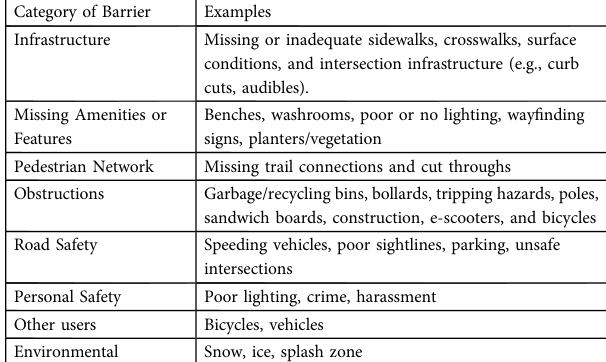
TABLE 1 Main categories of barriers from the stakeholder interviews.